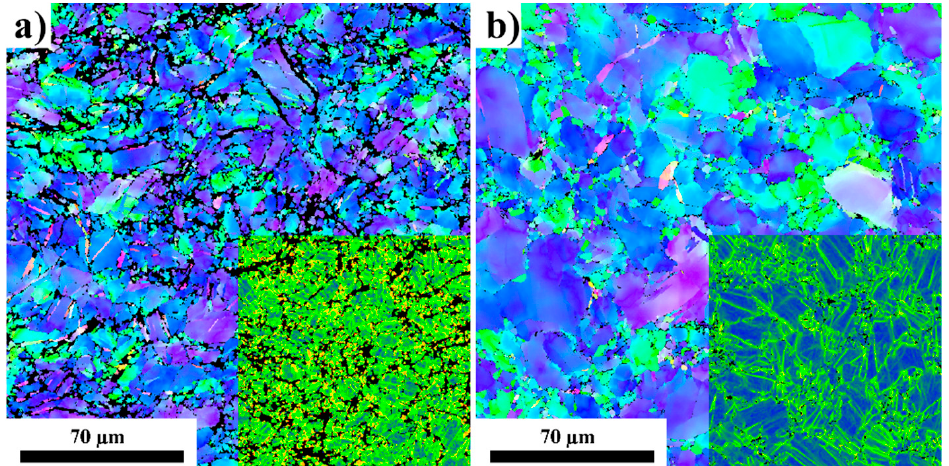
Figure 8. EBSD orientation maps of swaged ( a ) and swaged + aged ( b ) samples. Overlay of kernel average misorientation maps is presented in the bottom right corner of each orientation map (colour scale blue-green-red).